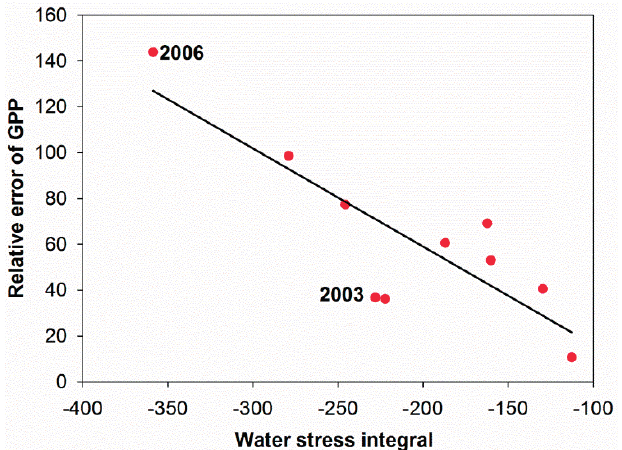
Figure A4. Linear relationship between the water stress integral WSI and the relative error in the yearly